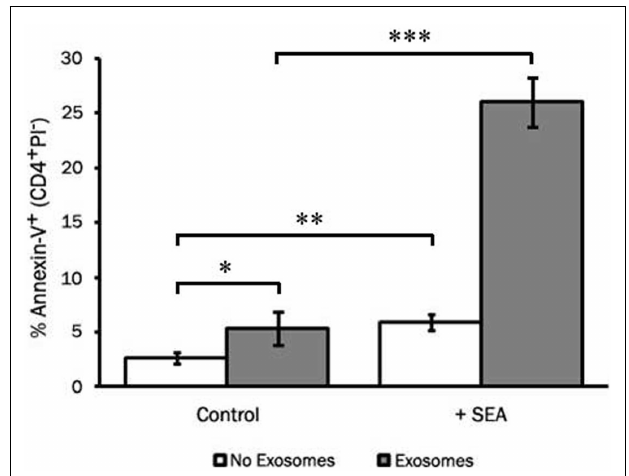
FIGURE 6 | LCL-derived exosomes can induce apoptosis in autologous CD4 + T cells. CD4 + T cells were harvested from a repeat donor from whom we had previously generated an LCL. CD4 + T cells were incubated with exosomes (127 µ g/mL) in the presence or absence of the super-antigen, staphylococcal enterotoxin A (SEA). After 6days in culture, PBMCs were harvested and apoptosis was assessed in CD4 + T cells by annexin-V/propidium iodide staining. Data are representative of three independent experiments using exosomes from this donor. Similar results were obtained using exosomes from a different LCL donor (data not shown). * p < 0.05, ** p < 0.01, *** p <